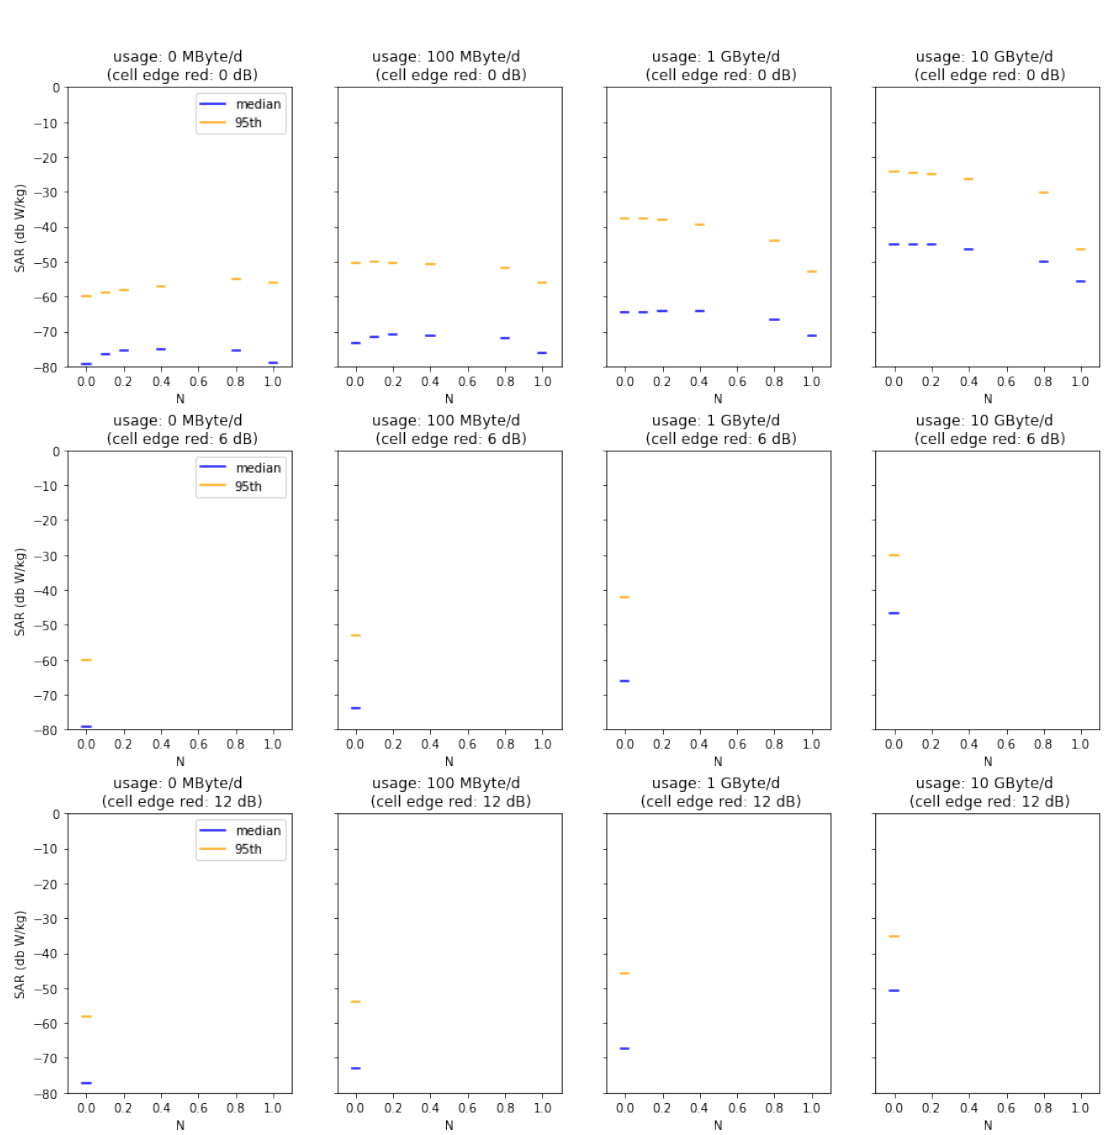
Figure A4. Median and 95th percentiles for varied usage, indoor coverage factor N , and cell size reductions in the urban-mini cell